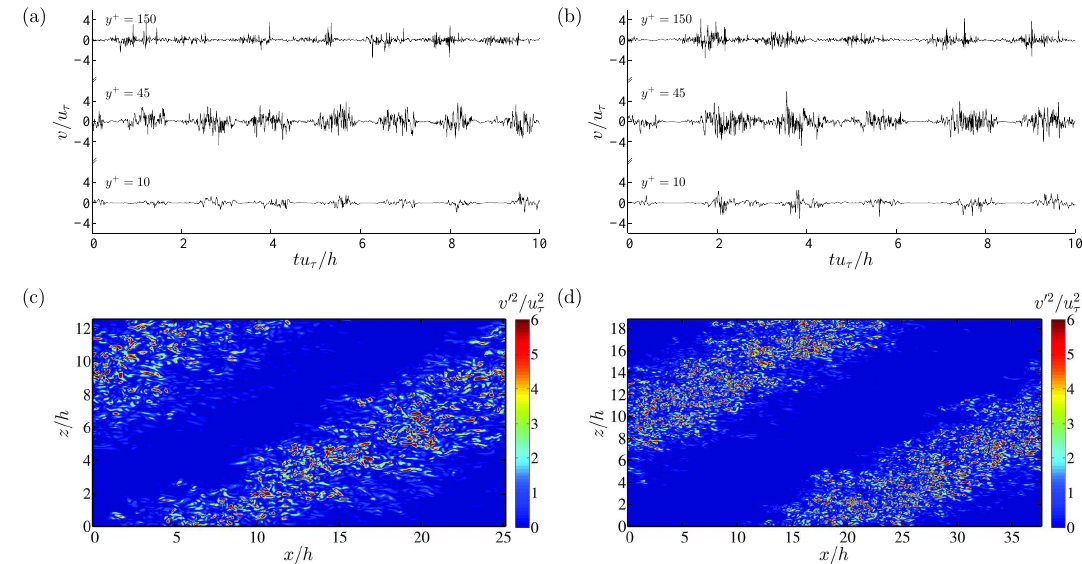
Figure B1. Influence of simulation configurations on the spatiotemporal characteristics of intermittency ( Re τ = 180, Ri τ = 120). (a) and (b) are time series of vertical velocity in the channel; (c) and (d) are instantaneous contours of v (cid:48) 2 at the x – z plane located at y + = 45. For (a) and (c), the horizontal grid resolutions are (cid:49)x + = 5 . 9 and (cid:49)z + = 2 . 9, and the domain sizes are L x /h = 8 π and L z /h = 4 π ; for (b) and (d), the horizontal grid resolutions are (cid:49)x + = 8 . 8 and (cid:49)z + = 4 . 4, and the domain sizes are L x /h = 12 π and L z /h = 6 π